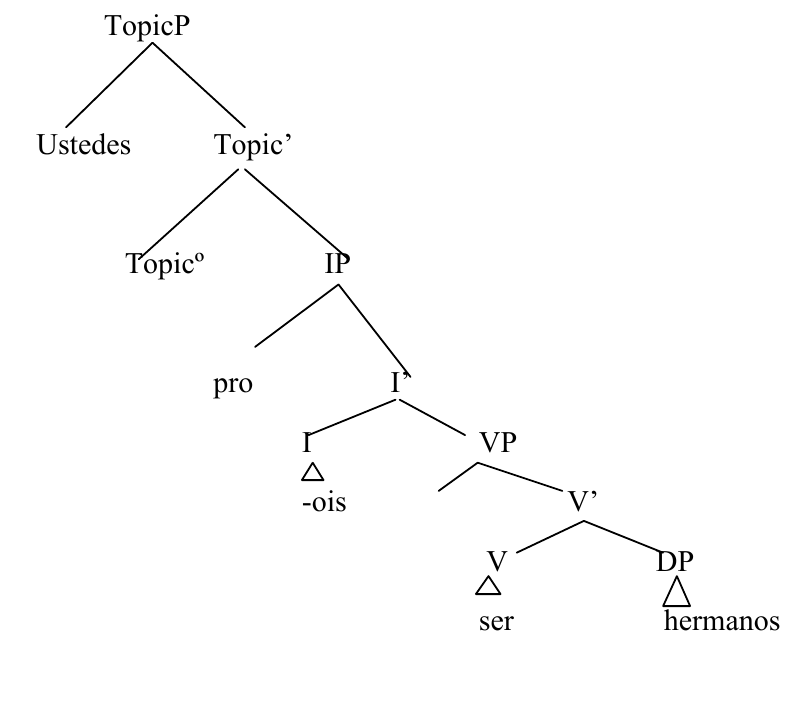
] sois hermanos 2pl